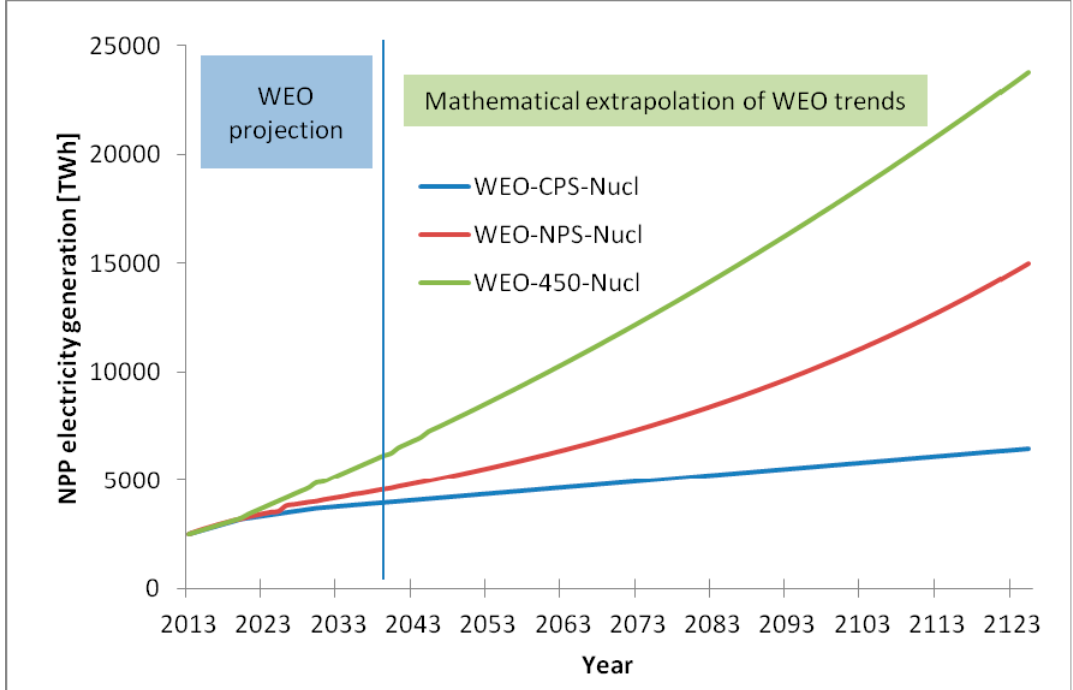
Figure 1. Forecast for electricity generation in nuclear power plants based on WEO 2015 scenarios.